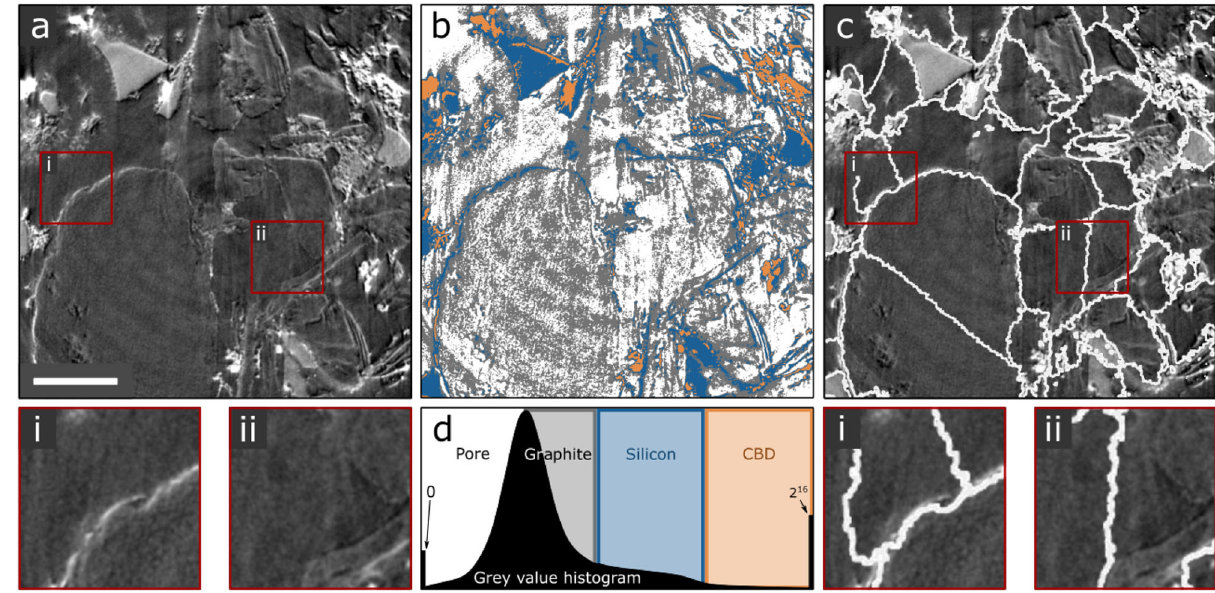
Fig. 2 Challenging segmentation. ( a ) A subsection of a tomogram of a graphite-silicon composite electrode imaged with XTM. Scale bar is 5 μ m. Neither ( b ) threshold- nor ( c ) random walker-based segmentation yield satisfying results. Low contrast regions are not split up accurately into particle regions (insets i and ii). ( d ) Gray value histogram of the tomogram and the proposed k-means clusters for the pore space (white), graphite particles (gray), silicon particles (blue), and carbon black-binder domain (CBD) (orange).